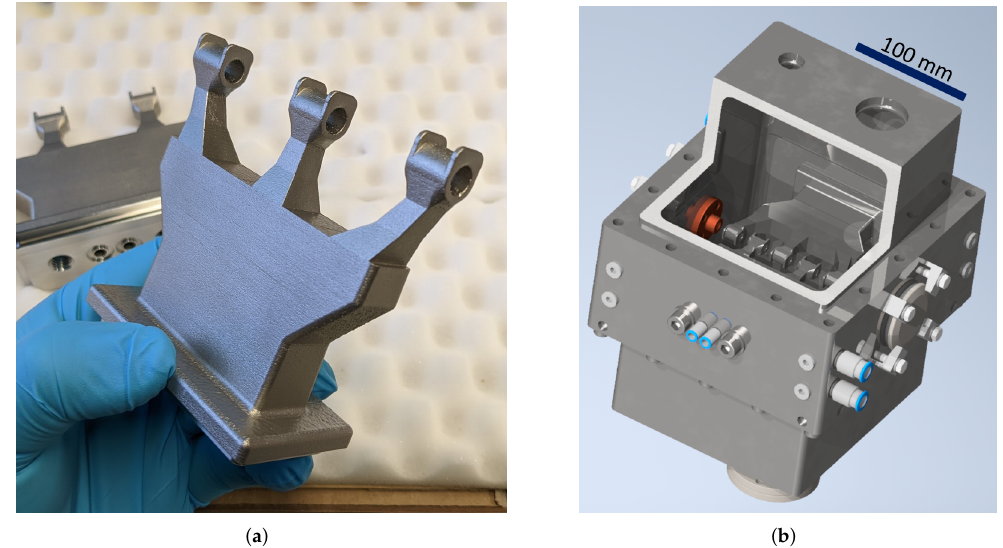
Figure 1. Overview of the cavity geometry and printed parts. ( a ) 3D printed girder drift tube structure. ( b ) Cross section of the assembled cavity